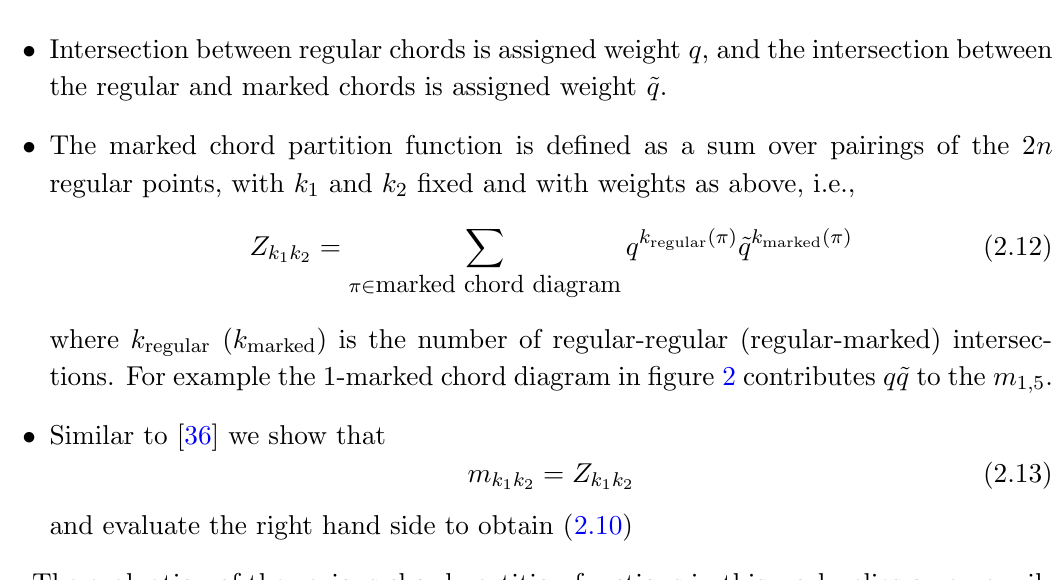
Figure 2 . A sample marked Chord